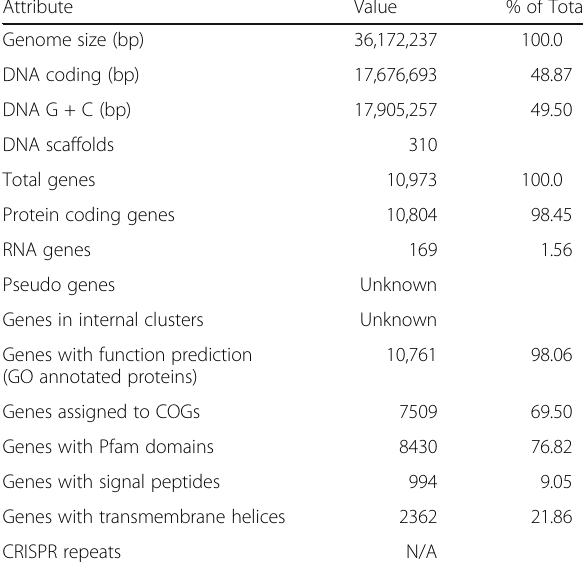
Table 3 Genome statistics